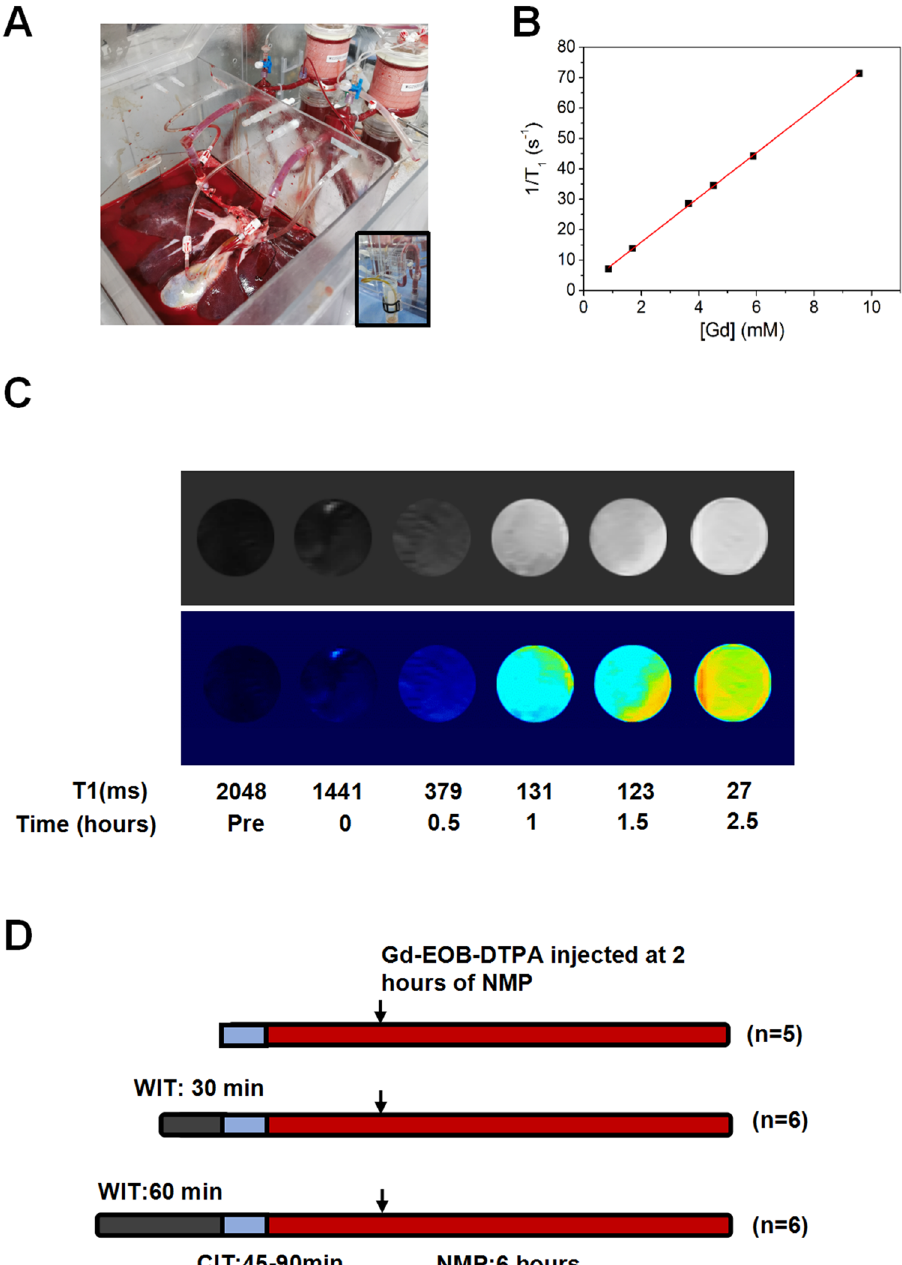
Figure 1. Dynamic change of biliary R1 correlates significantly with the concentration of Gd in bile during NMP. ( A ) Representative image of a liver graft in the NMP device. Bile samples were collected dynamically. ( B ) After Gd-EOB-DTPA was injected in the circulated perfusate 2 h after initiation of NMP, six bile samples were collected at different time points. The T1 relaxation time of the bile samples were measured using an NMR relaxation analyzer. Gd concentration in corresponding samples was analyzed via inductively coupled plasma- atomic emission spectrometry (ICP-AES). Significant linear correlation between Gd concentration and biliary relaxation rate (R1 = 1/T1) is shown (residual sum of squares = 0.73925; Adj. R-square = 0.99965; 1/T1 Intercept: 1.30671, slope: 7.3405). ( C ) T1-weighted MR images of the bile samples. Corresponding T1 value and the time point for sample collection after Gd-EOB-DTPA injection of each bile sample are listed below. ( D ) The basic model for viability test of liver grafts during NMP. Livers were obtained after draining the blood. Following 0 min, 30 min and 60 min of warm ischemia and 45–90 min of cold ischemia (preparing process), livers were allowed to cannulate to NMP and divided into 3 groups (WIT:0 ′ , n = 5; WIT:30 ′ , n = 6; WIT:60 ′ , n = 6). Gd-EOB- DTPA was injected 2 h after starting NMP, and bile samples were collected for R1